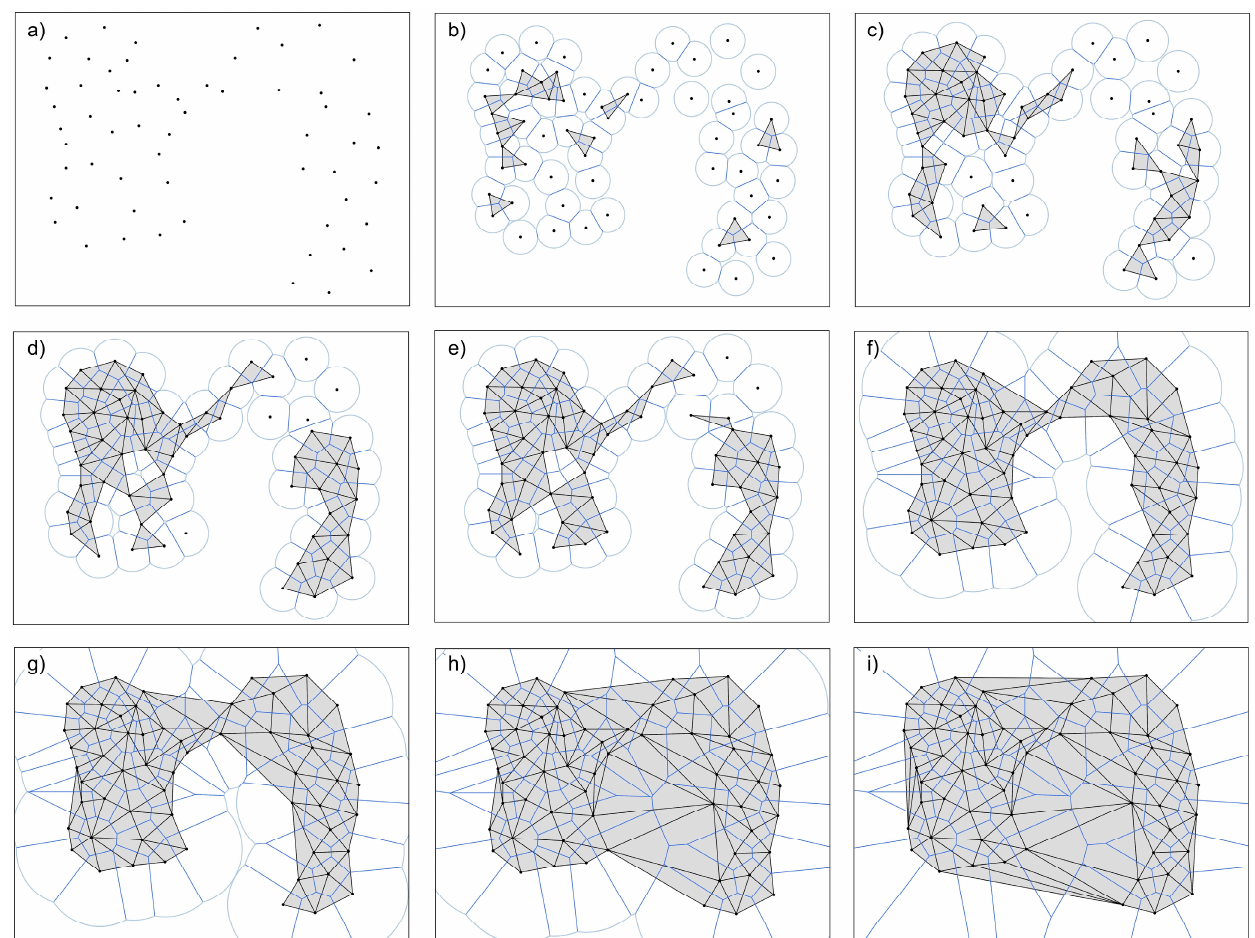
Figure 5. Restricted Voronoi diagrams and their resulting Delaunay Triangulations producing the triangulated Alpha Shape, adapted from Royer [65]. ( a ) a zero Alpha Radius producing an empty Alpha Shape; ( b – h ) an increase in Alpha Radius from left to right, and top to bottom, respectively; ( i ) an infinite Alpha Radius producing the Convex Hull. Visualization aided by the Scipy Spatial [66] and Matplotlib [67] libraries for Python.